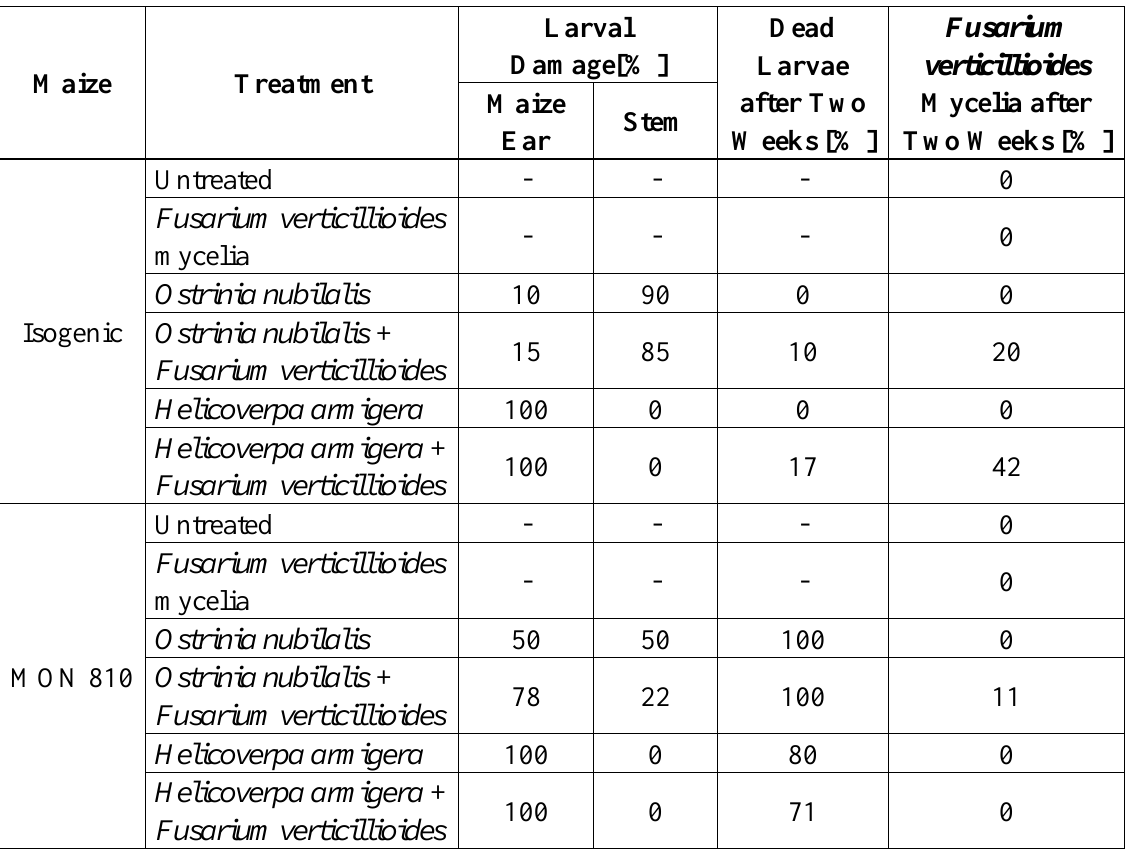
Table 1. Fusarium verticillioides infestation transmitted by Helicoverpa armigera or Ostrinia nubilalis larva in maize ear isolator *